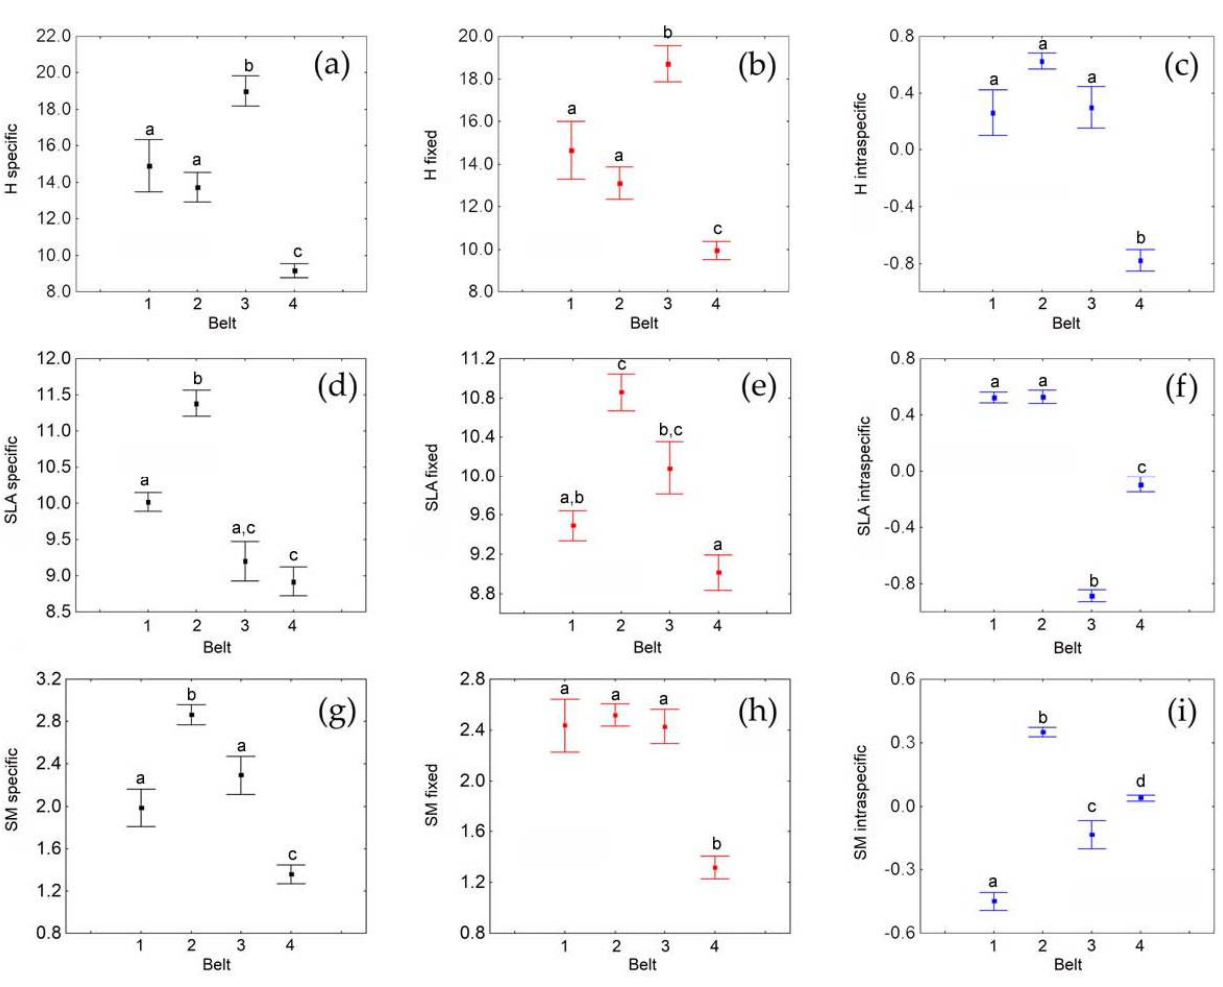
Figure 2. Averages and standard errors of community nonweighted mean (CM) values in the four elevational belts (elevation: 1, 2, 3, 4) calculated for plant height (H: a , b , c ), specific leaf area (SLA: d , e , f ) and seed mass (SM, g , h , i ), along an elevational gradient in Central Italy. CMs were calculated for the specific variability ( a , d , g ), the fixed component ( b , e , h ) and the intraspecific variability ( c , f , i ). Letters indicate Tukey HSD post-hoc tests at the p < 0.05 level, following ANOVA.